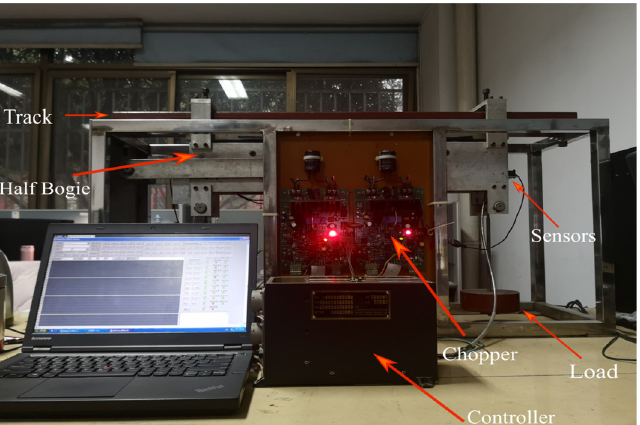
Figure 1. Equiproportionally reduced suspension experimental platform.